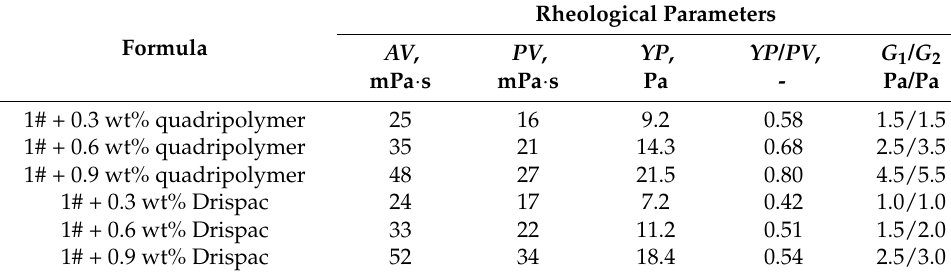
Table 3. Influence of polymer concentration on rheological behavior of base formula.